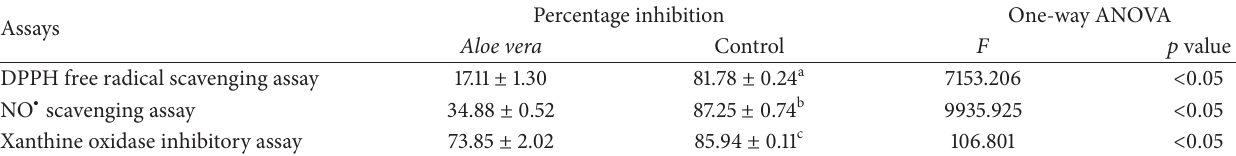
Table 5: Antioxidant activity of Aloe vera .